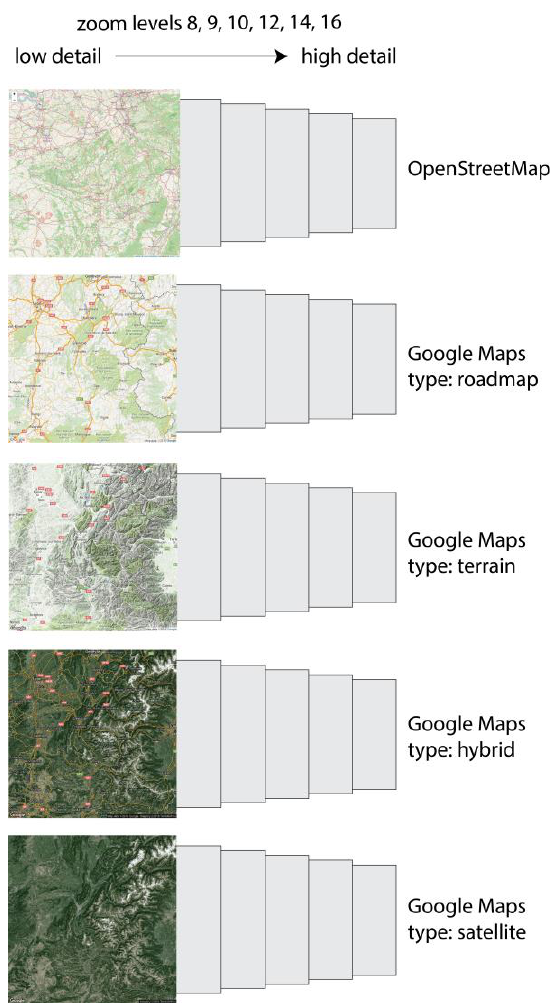
Figure 1. Analyzed geovisualization types in the Phase 1.